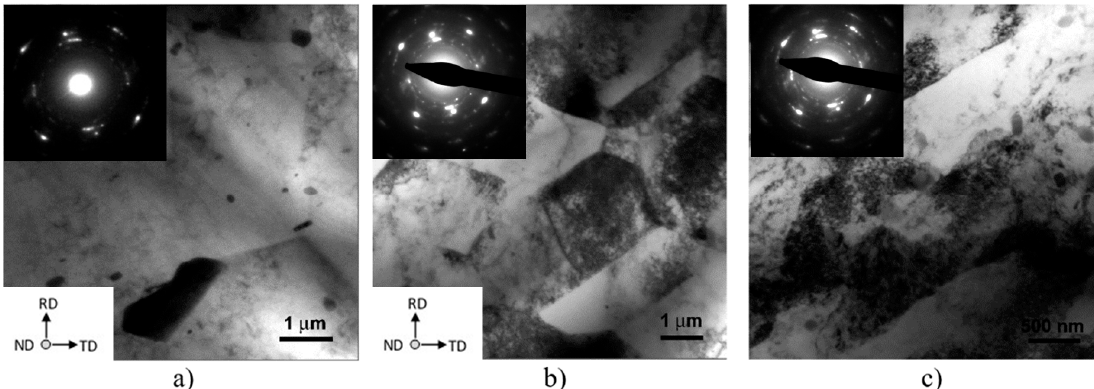
Figure 4. TEM representative micrographs of the nugget zone of ( a ) FSW 2 , ( b ) FSW 2 -CR ( ε = 1.08), and ( c ) ECAP-1 ( ε = 1.08) inspected in the X-plane. RD, TD, and ND were the same for all the three micrographs. In all three cases, Selected-Area Diffraction Patterns (SAEDPs) were recorded with equal aperture size of 800 nm and same Al-[002] crystallographic orientation. In ( c ), the ECAP pressing direction is horizontal, from left to right.